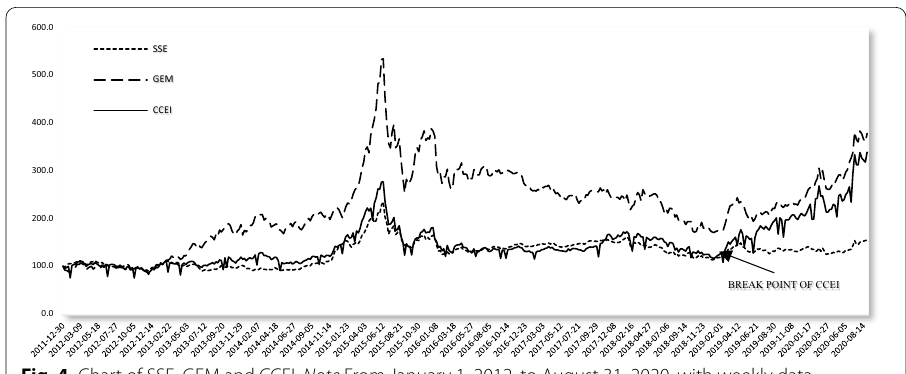
Fig. 4 Chart of SSE, GEM and CCEI. Note From January 1, 2012, to August 31, 2020, with weekly data